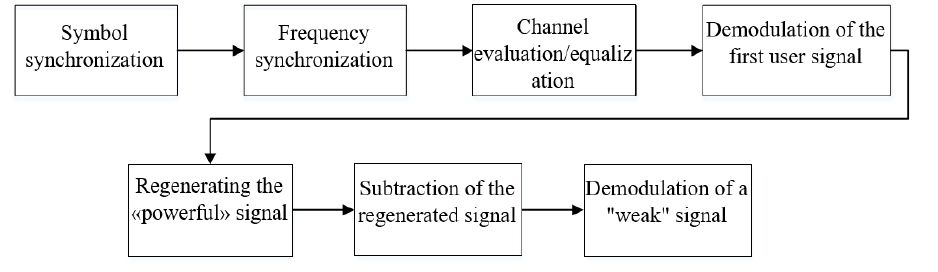
Fig. 1. PD-NOMA signal processing block